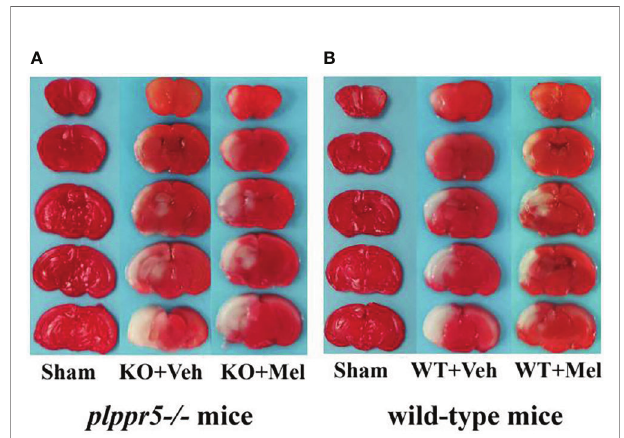
FIGURE 3 | Photomicrographs of TTC-stained coronal slices showing brain infarction 24 h after HI: (A) plppr5 − / − mice; (B) Wild-type mice. WT, wild-type mice with HI injury; KO, knockout mice with HI injury; Mel, melatonin; Veh, vehicle.